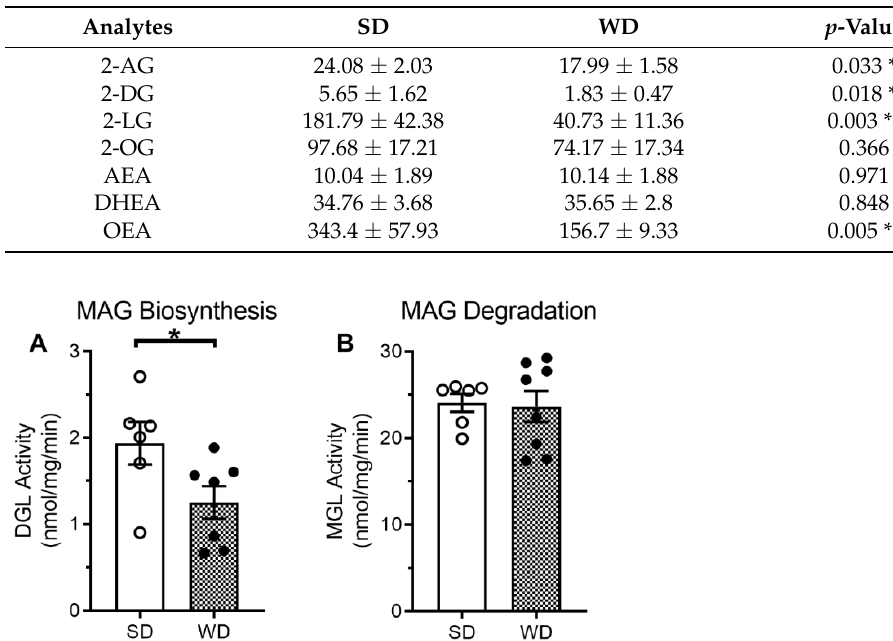
Table 1. UPLC/MS/MS analysis of endocannabinoid content in the large intestinal epithelium of mice fed SD or WD. MAGs (2-AG, 2-DG, 2-LG, 2-OG) represented as nmol per g tissue; FAEs (AEA, DHEA, OEA) represented as pmol per g tissue. Data analyzed via two-tailed unpaired student’s t -test; * = p < 0.05, ** = p < 0.01; n = 5–8 per condition. SD = standard diet, WD = western diet.